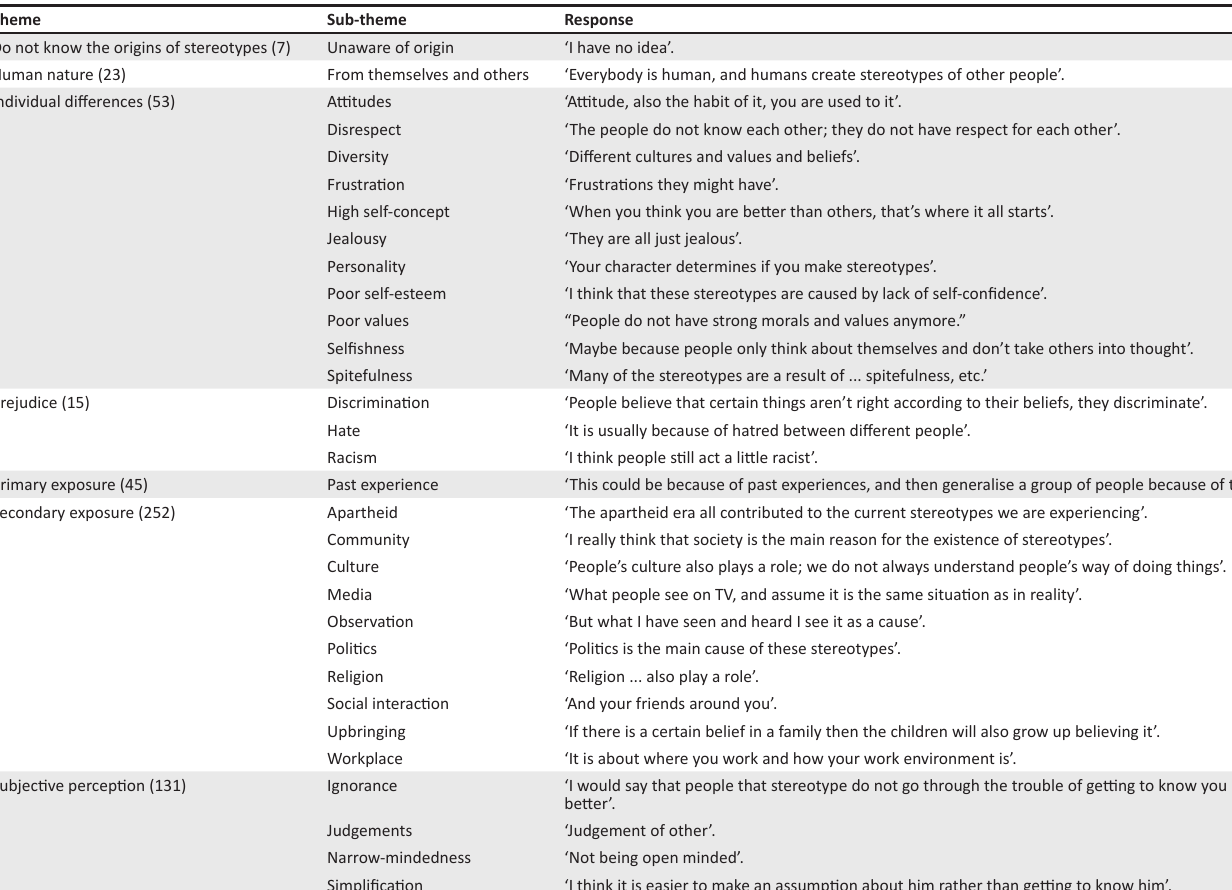
TABLE 3: Origin of